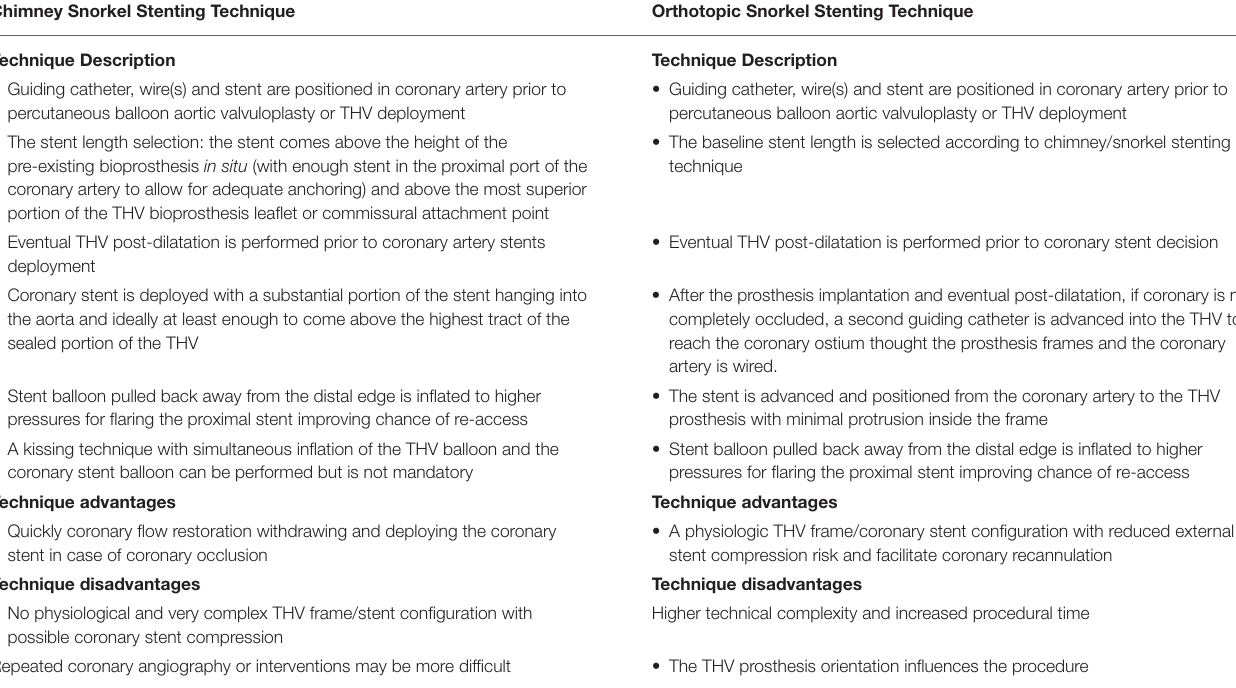
TABLE 1 | Steps, advantanges and diadvantages of the stenting techniques during coronary protection in VIV-TAVI procedures. Chimney Snorkel Stenting